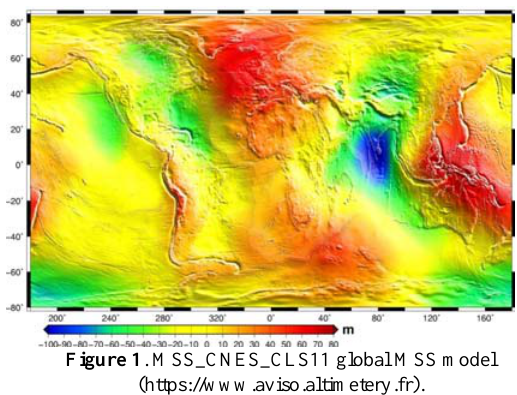
Figure 1 . MSS_CNES_CLS11 global MSS model